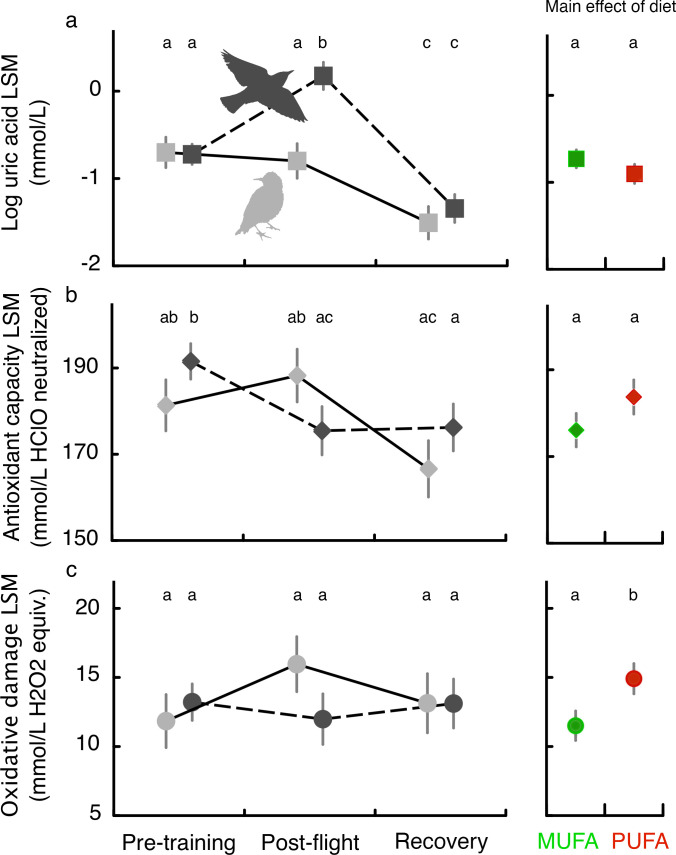
Oxidative status of European starlings associated with flight-training and in relation to diet quality.Oxidative status (see Materials and methods, Experiment II) of MUFA-fed or PUFA-fed European starlings was measured in blood plasma at three different time points for flight-trained (black symbols and dashed lines) and untrained, sedentary control (gray symbols and lines) birds: before the start of flight training in the windtunnel (Pre-training), immediately after a long-duration flight on Day 15 (Post-flight), and ca. 1.5 days afterwards (Recovery). Untrained sedentary birds were sampled on the same days but were never exposed to flight-training. Body mass and date of measurement were included as a fixed covariate so we report the results as least square means (LSM). The comparison of Recovery and Post-flight timepoints reveals the effect of the long-duration flight: birds had very similar total flight times over the 15 days of exercise training with the primary difference being whether we sampled the bird’s blood immediately after flight (Post-flight) or 2 days after their final flight (Recovery). The main effect of diet (MUFA vs. PUFA) on oxidative status is shown in the right panels. Means with different letters across the three timepoints, or for the main effect of diet, are significantly different (p<0.05).